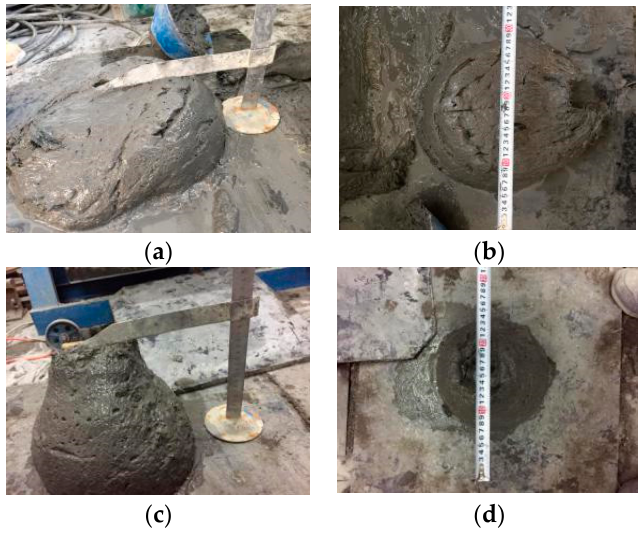
Figure 9 . Comparison of RPC workability with different steel fiber dosages: ( a ) steel fiber content of 2%; ( b ) steel fiber content of 2%; ( c ) steel fiber content of 5%; ( d ) steel fiber content of 5%.